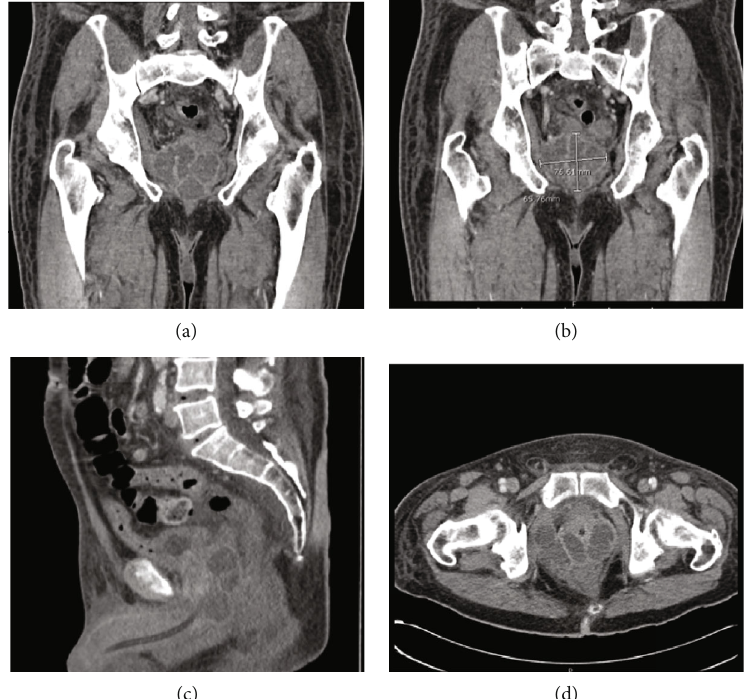
Figure 1: CT of the pelvis with contrast showing the multiloculated prostatic abscess in: (a) coronal view, (b) coronal section with measurements, (c) sagittal view showing involvement of the right perirectal/perianal region, and (d) axial view showing invasion of the right pelvic sidewall/obturator